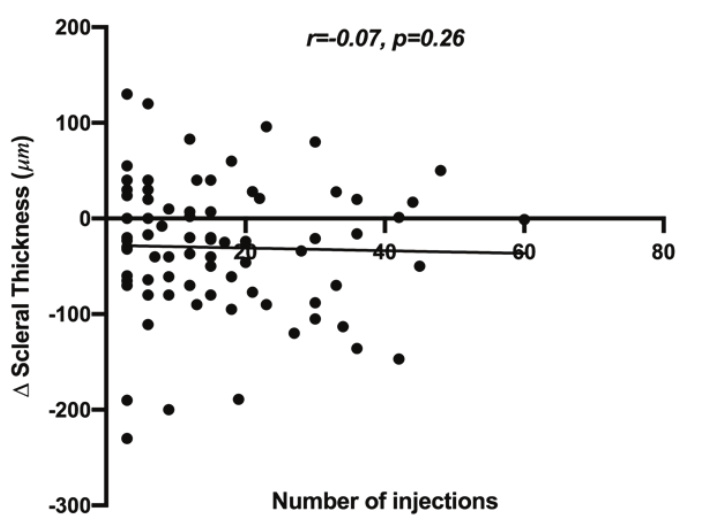
Figure 1. Correlation of number of injections with scleral thickness change in injected and injection-naïve fellow eye ( Δ = difference, n = 79, Spearman r = –0.072, P = 0.263).